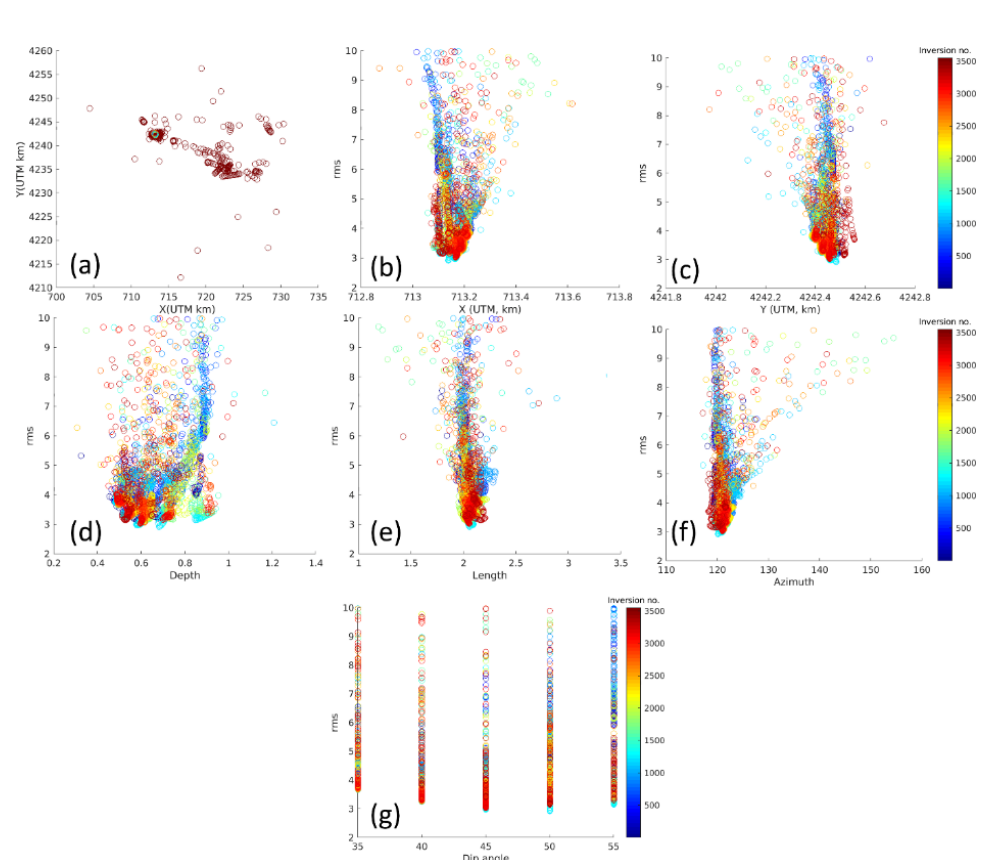
Figure A2. Divergence diagrams of the set of control group of inversions for ( a ) planar position, ( b ) X in UTM, ( c ) Y in UTM and ( d – g ) for depth, length, azimuth and dip angle, accordingly (all versus standard deviation). Color-coding refers to the inversion